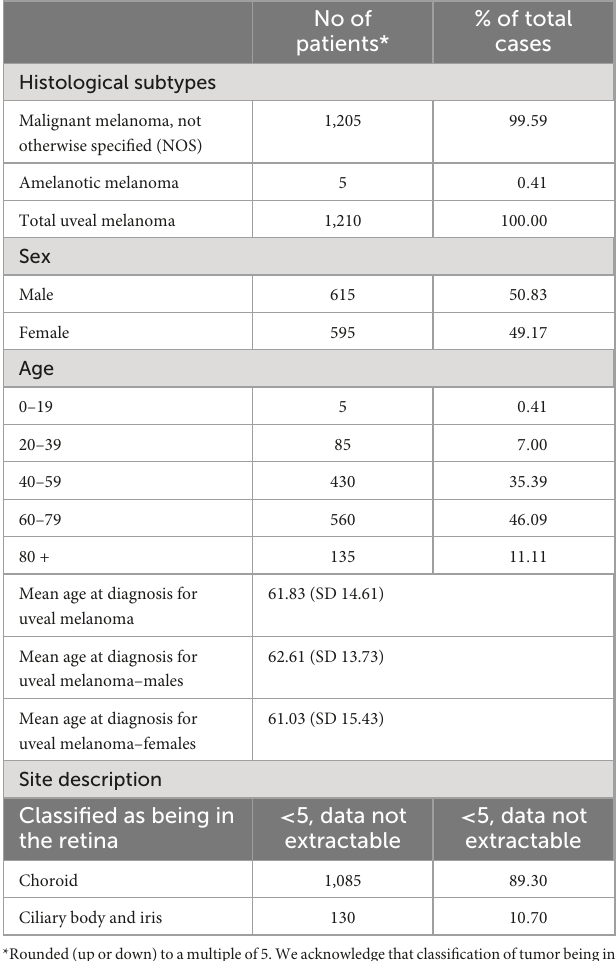
No of % of total patients*